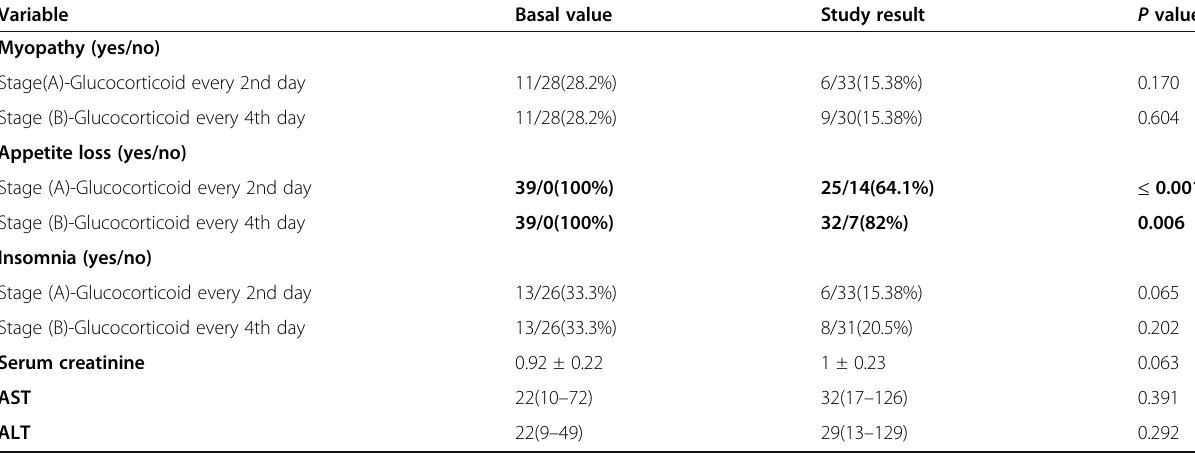
Table 3 Glucocorticoid side effects